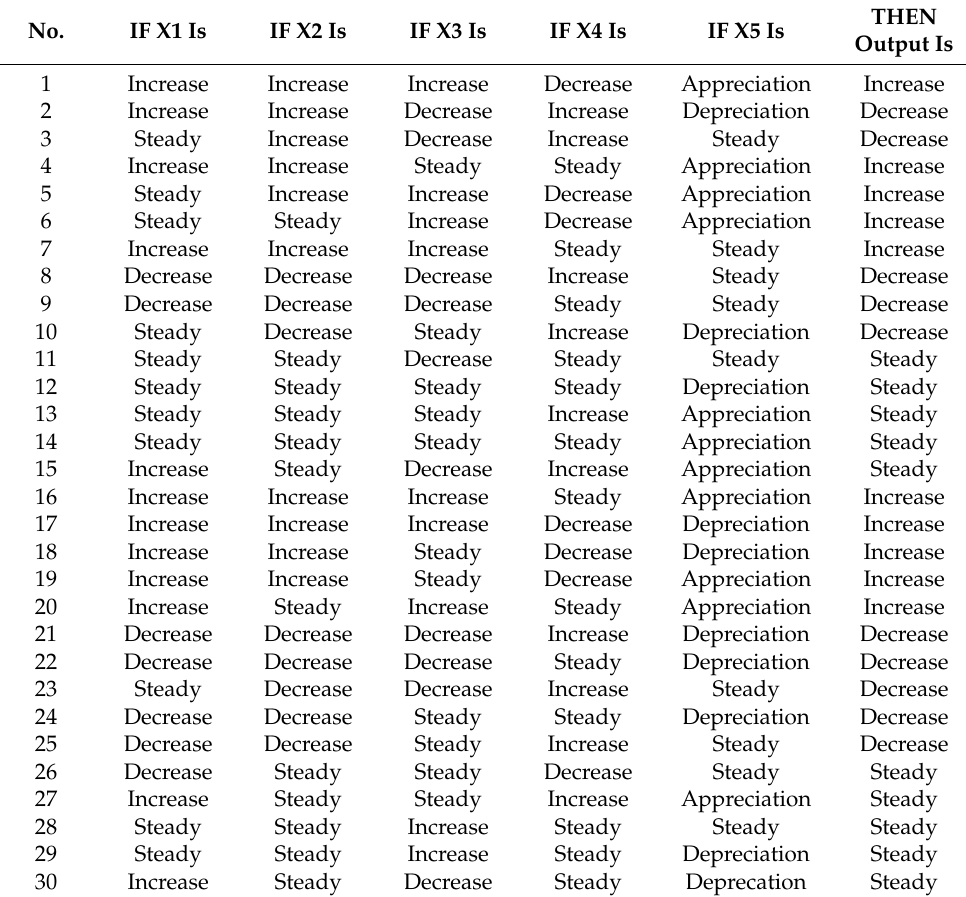
Table 2. The exemplary set of decision rules of the fuzzy logic model. Source: based on the author’s own